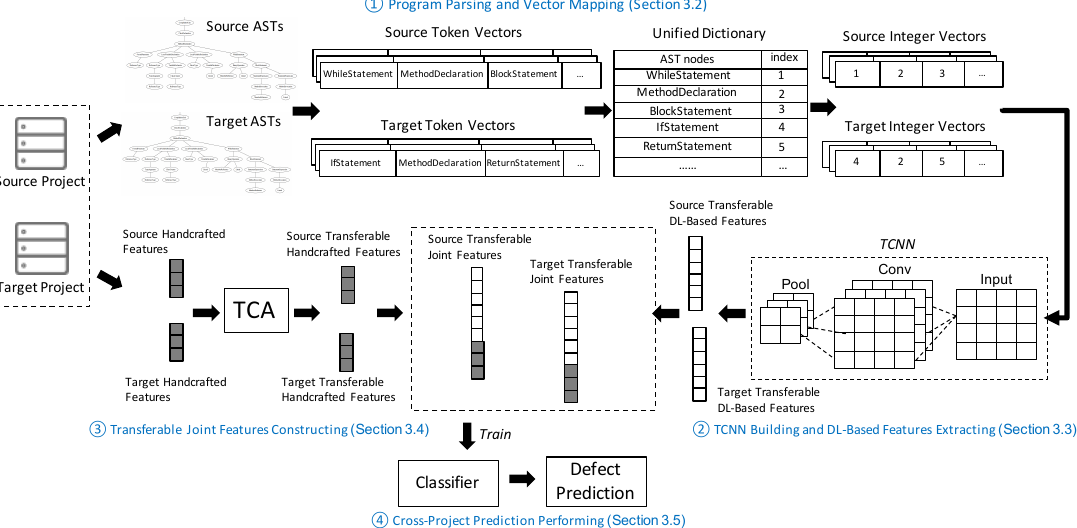
Figure 2. Overview of our TCNN framework to perform CPDP. AST, abstract syntax tree; TCNN, transfer convolutional neural